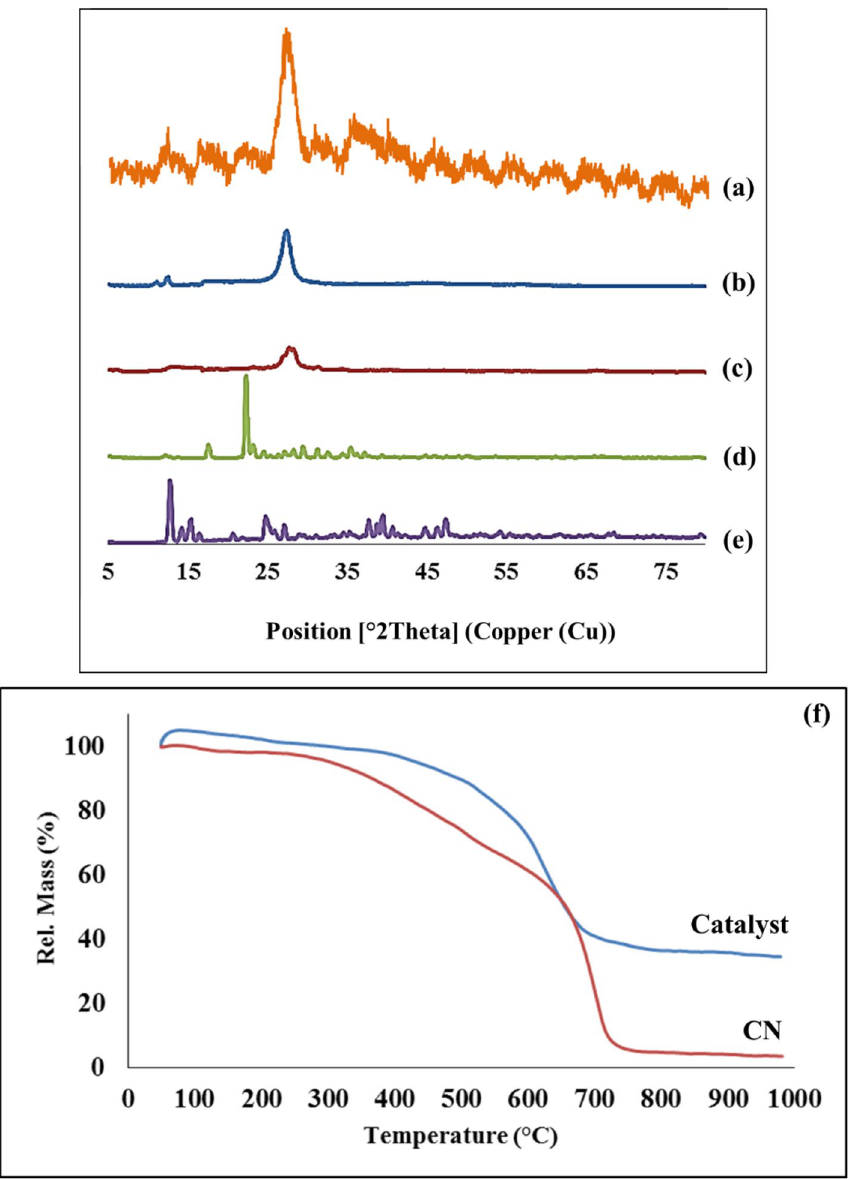
Figure 5. XRD pattern of (a) prepared CN–Pr–Met–Cu(II), (b) bulk g-C 3 N 4 , (c) CN, (d) Metformin, and (e) Cu(II) acetate hydrate. (f) TG analysis of the CN–Pr–Met–Cu(II) and